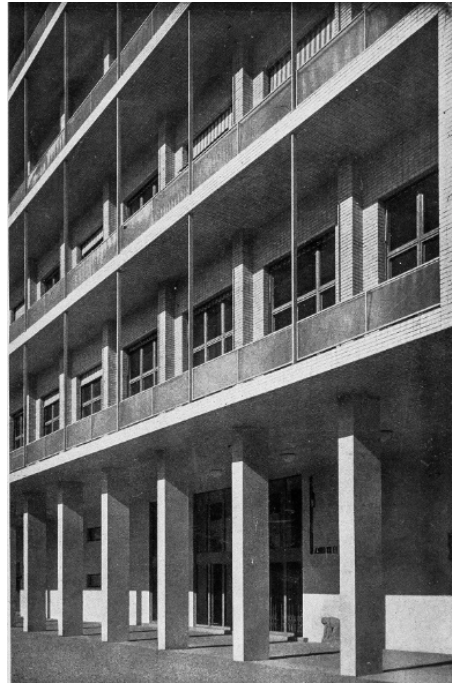
Figure 34. The block of offices. Lithoceramic coating, wooden window frames, parapets in safety glass. Photo from (Pagano Pogatschnig 1942, p. 7).